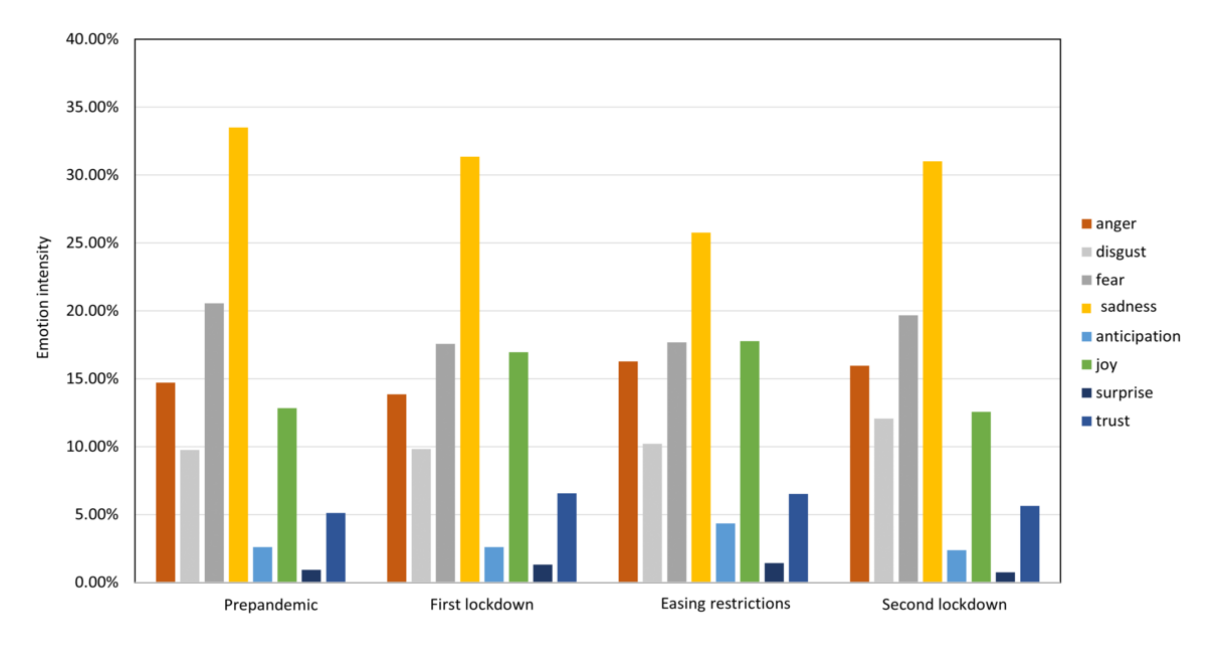
Figure 3. Emotion intensity fluctuations over time.